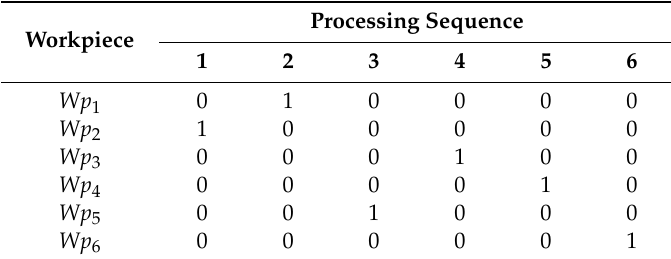
Table 1. FFSP permutation matrix of six workpieces.